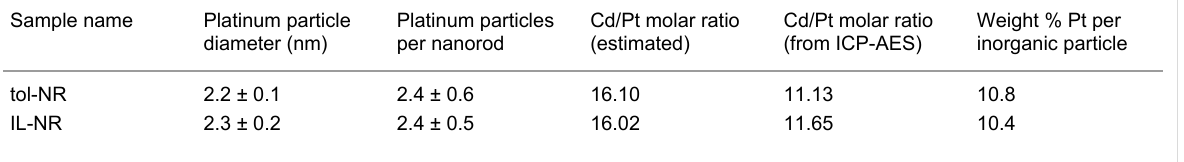
Table 1: Comparison of sample composition determined by TEM and